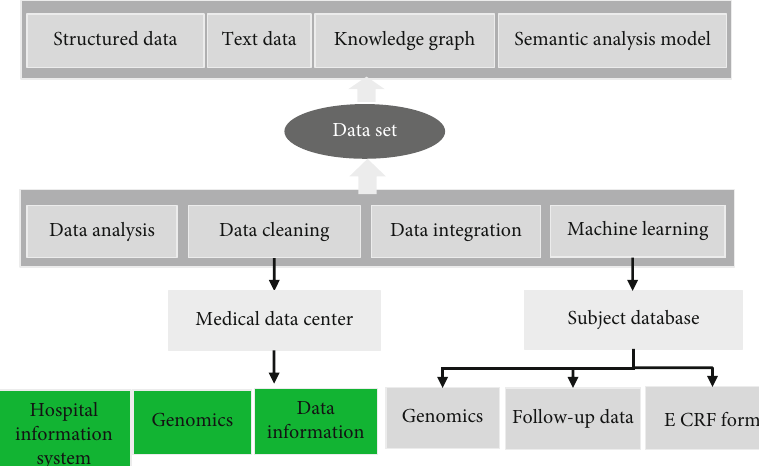
Figure 1: Architecture of big data analysis platform.